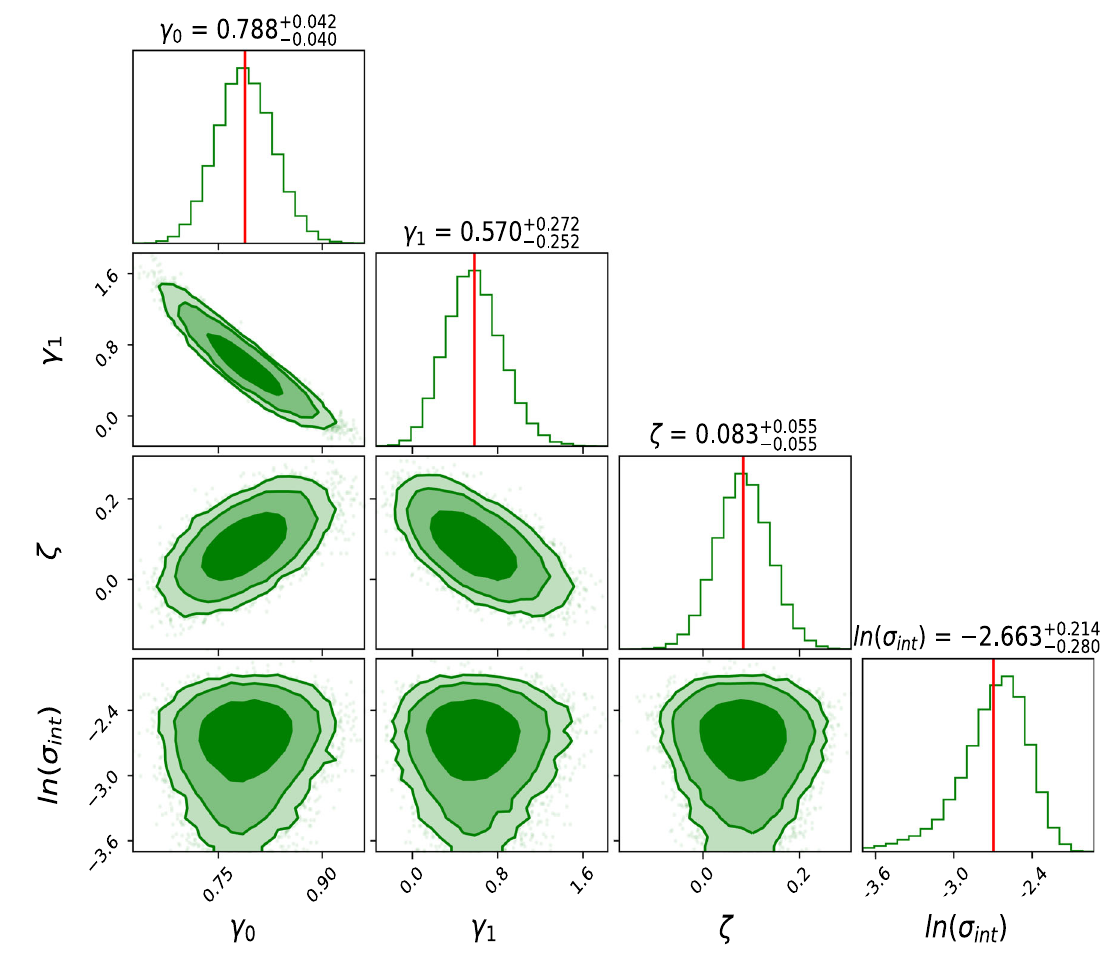
Fig. 8 Same as Fig. 7 for the Planck ESZ